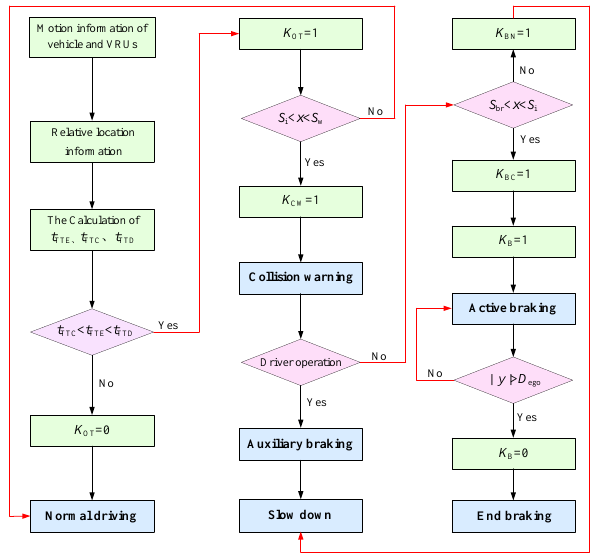
Figure 3. Automobile collision avoidance strategy.